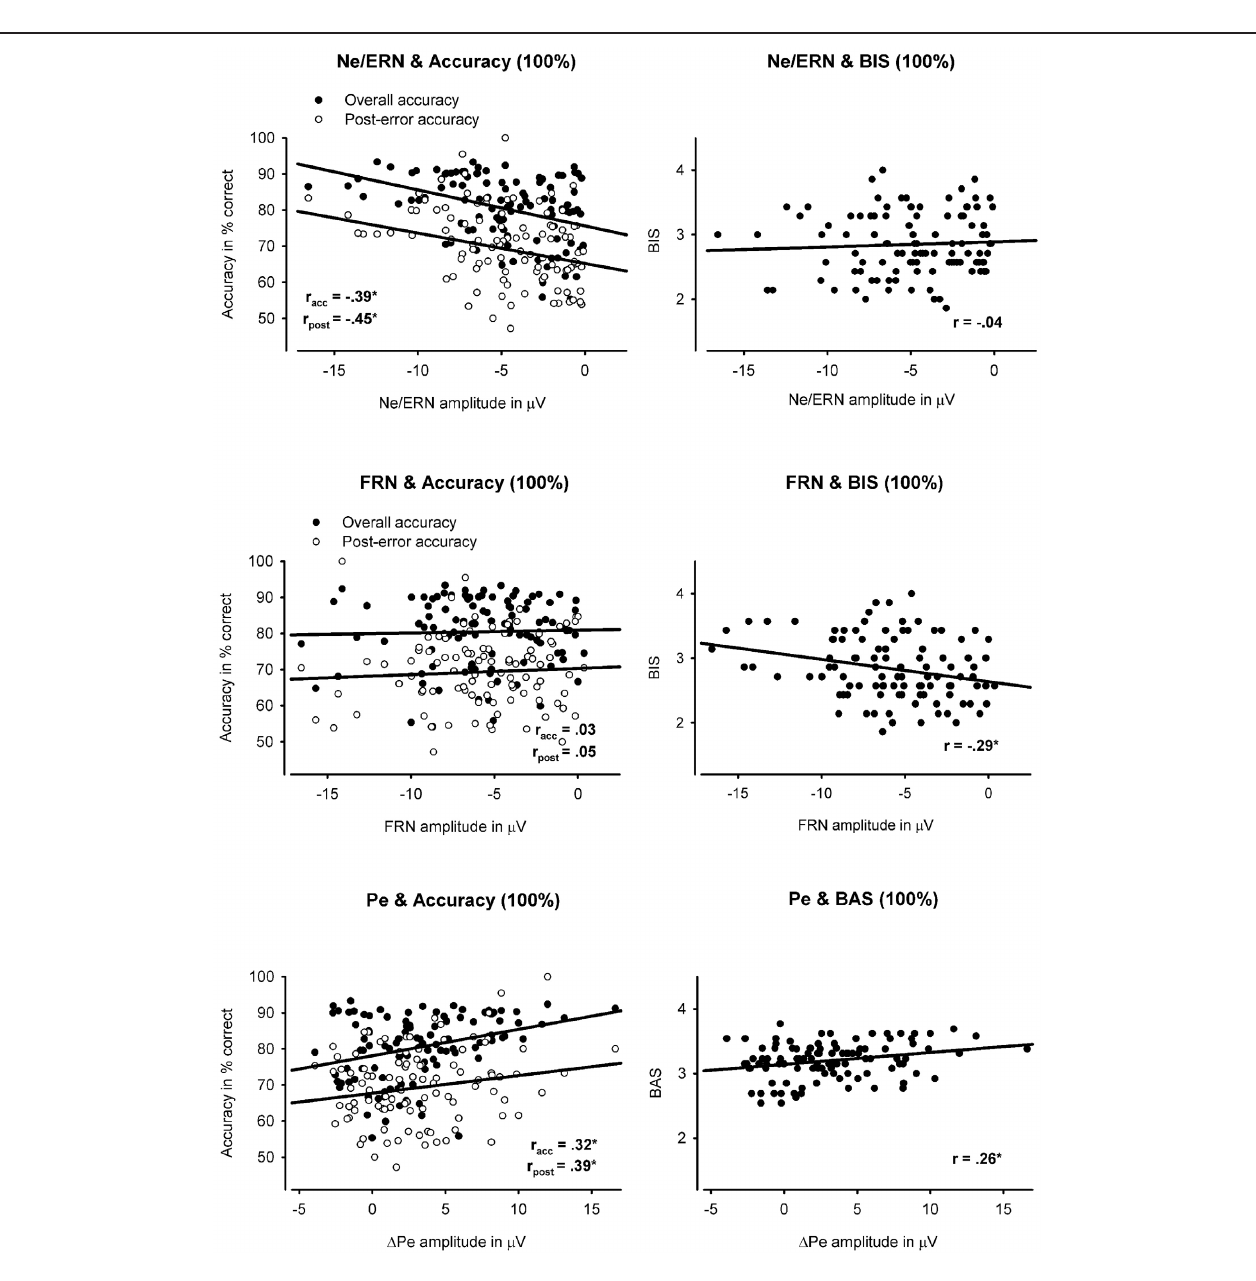
FIGURE 4 | Scatterplots showing the relationships between the ERP components (Ne/ERN, FRN, Pe) and learning performance (overall accuracy, post-error accuracy), and personality (BIS, BAS). The first row shows the correlation between the Ne/ERN (measured peak-to-peak) and